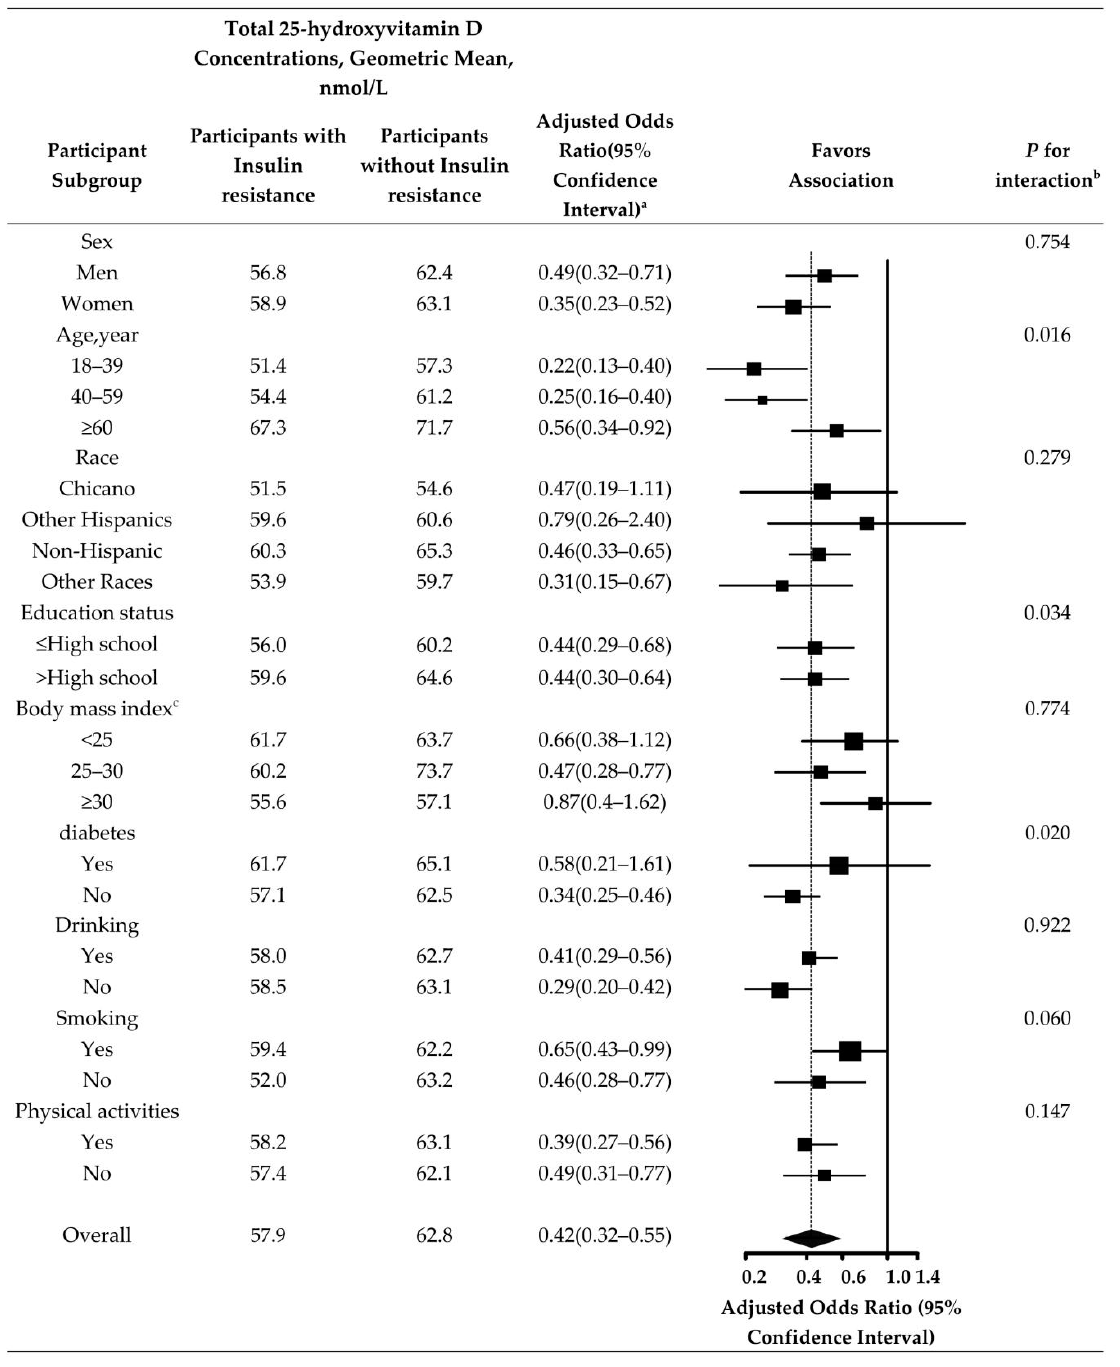
Figure 1. Total 25-hydroxyvitamin D Concentrations Comparing Participants With insulin resistance. a Odds Ratio (95% confidence interval) is also adjusted for creatinine (urine), albumin (urine), and cholesterol. b P for interaction based on log-transformed total 25-hydroxyvitamin D concentrations. c Body mass index is calculated as weight in kilograms divided by height in meters squared.